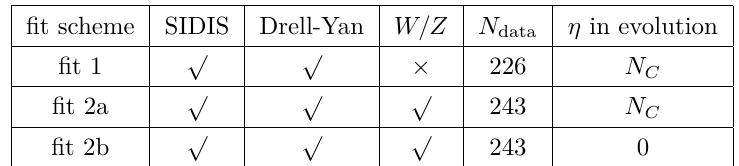
Table 1 . Description of each of the fits that we present. Fit 1 is presented in section 4.1, fit 2a is presented in section 4.3, and fit 2b is presented in section 4.4.